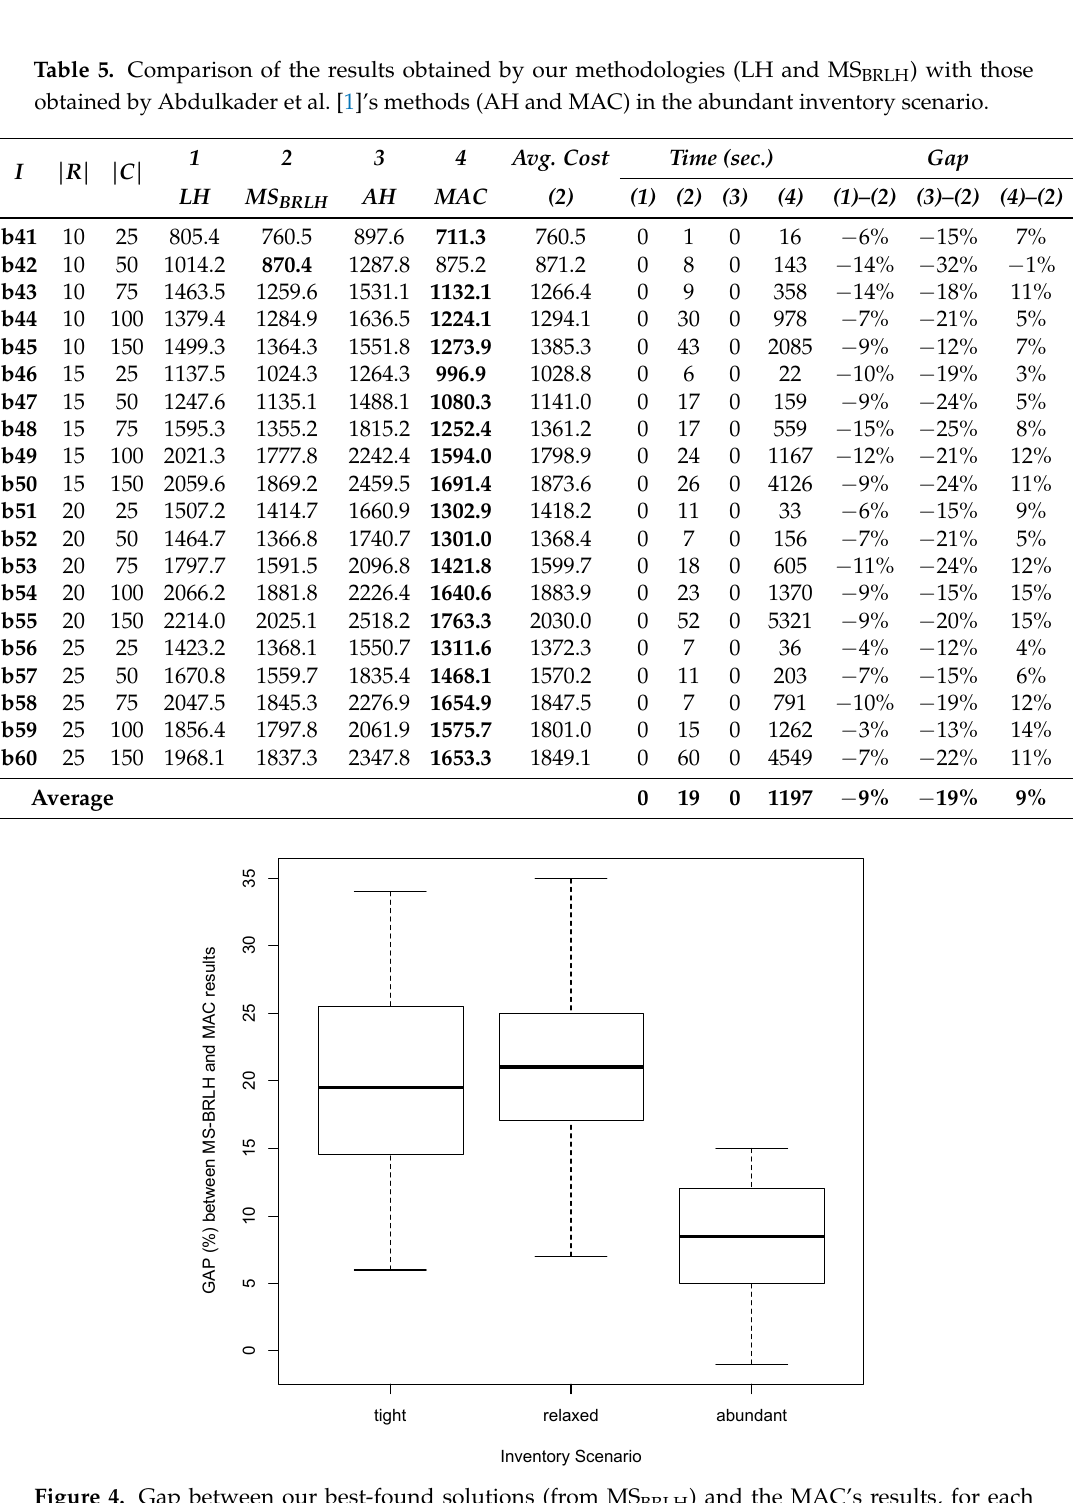
Figure 4. Gap between our best-found solutions (from MS BRLH ) and the MAC’s results, for each inventory